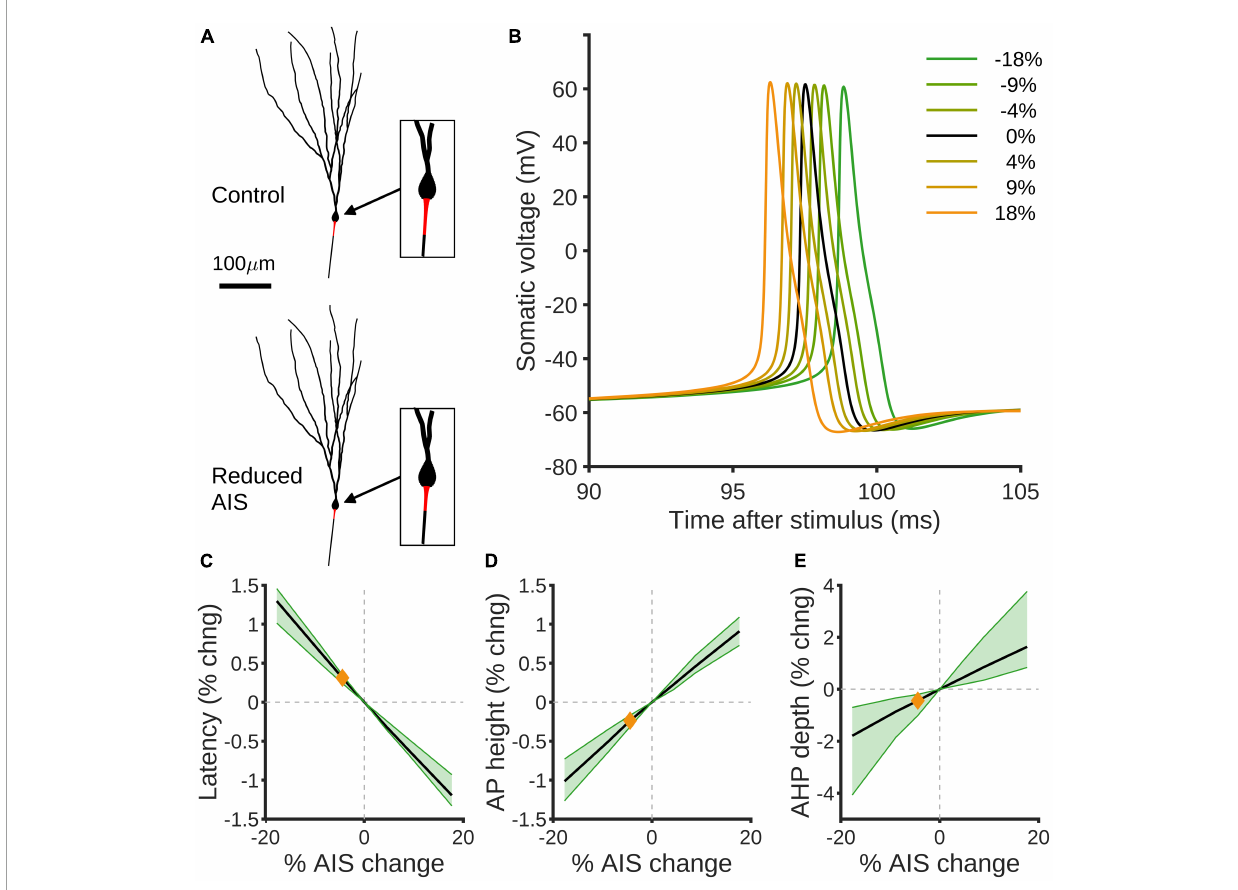
FIGURE4 Compartmental modeling predicts effects of AIS size reduction on spiking properties of GCs. (A) Example rat granule cell morphology (Beining et al., 2017a) with control (top) and 18% reduced (bottom) AISs highlighted in red. (B) Simulated somatic voltage traces in response to somatic current injection. The black curve shows the control morphology, green curves show reduced AISs and orange curves increased AISs. (C) Percentage change in spike latency as a function of percentage change in AIS size. Black shows the mean effect, green the 90% confidence interval over different morphologies, and the orange diamond indicates the effect of the observed experimental reduction in AIS size by 4.42%. (D,E) Percentage changes in spike height (D) and after-hyper polarization depth (E) as a function of percentage change in AIS. Colors as in panel (C) .